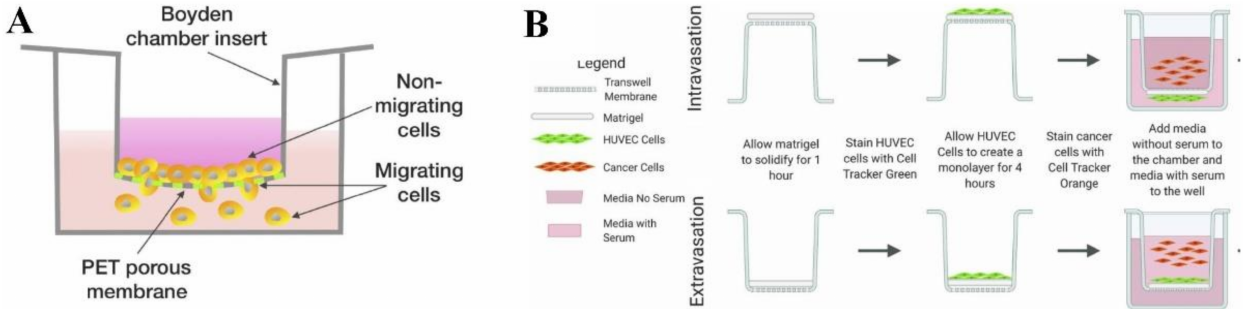
Figure 1. Transwell-based cancer model. ( A ) Basic cell invasion assay. Adapted with permission from [14] © Creative Commons Attribution License (2020). ( B ) Intravasation and extravasation assays. Adapted with permission from [18] © Creative Commons Attribution License